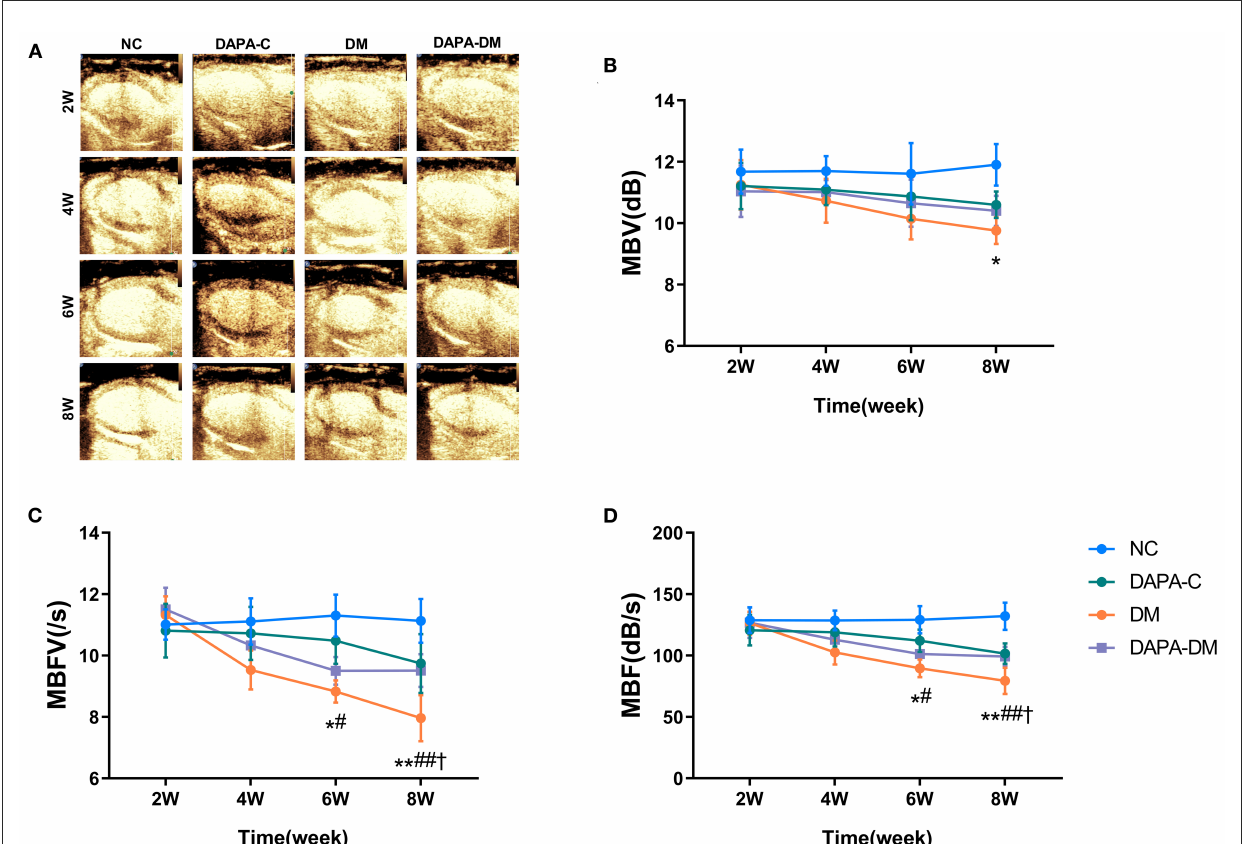
FIGURE4 Myocardial perfusion assessed by MCE. (A) Representative MCE-based myocardial perfusion images of the four groups at different time points. (B) Differences in the MBV among the four groups at different time points. (C) Differences in MBFV among the four groups at different time points. (D) Differences in MBF among the four groups at different time points. MBV, myocardial blood volume; MBFV, myocardial blood flow velocity; MBF, myocardial blood flow; NC, normal control group; DAPA-C, DAPA-control group; DM, diabetic group; DAPA-DM, DAPA-diabetic group. * p < 0.05, ** p < 0.01 vs. normal control group; † p < 0.05 vs. DAPA-control group; # p < 0.05, ## p < 0.01 vs. diabetic group at 2